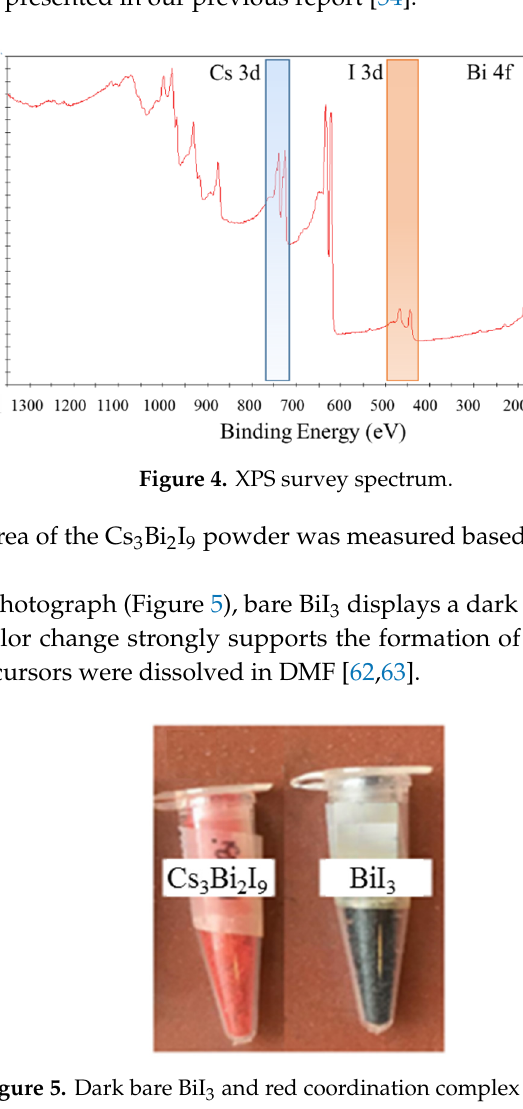
Figure 5. Dark bare BiI 3 and red coordination complex Cs 3 Bi 2 I 9 .